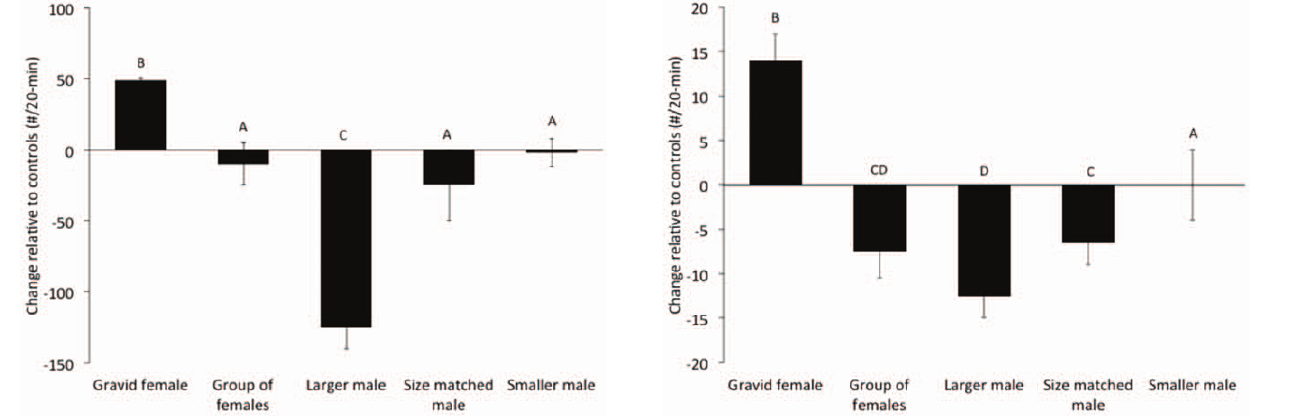
Figure 4. Overt aggressive acts. Number of overt aggressive acts (biting and ramming) displayed by signaling males in the presence of different audiences. The number of over aggressive acts varied across all audience types and the letters above the bars represent significant differences at a =0.05. Differences in the number of aggressive acts performed in the presence of a group of females, size-matched males or smaller males did not differ from the control condition.